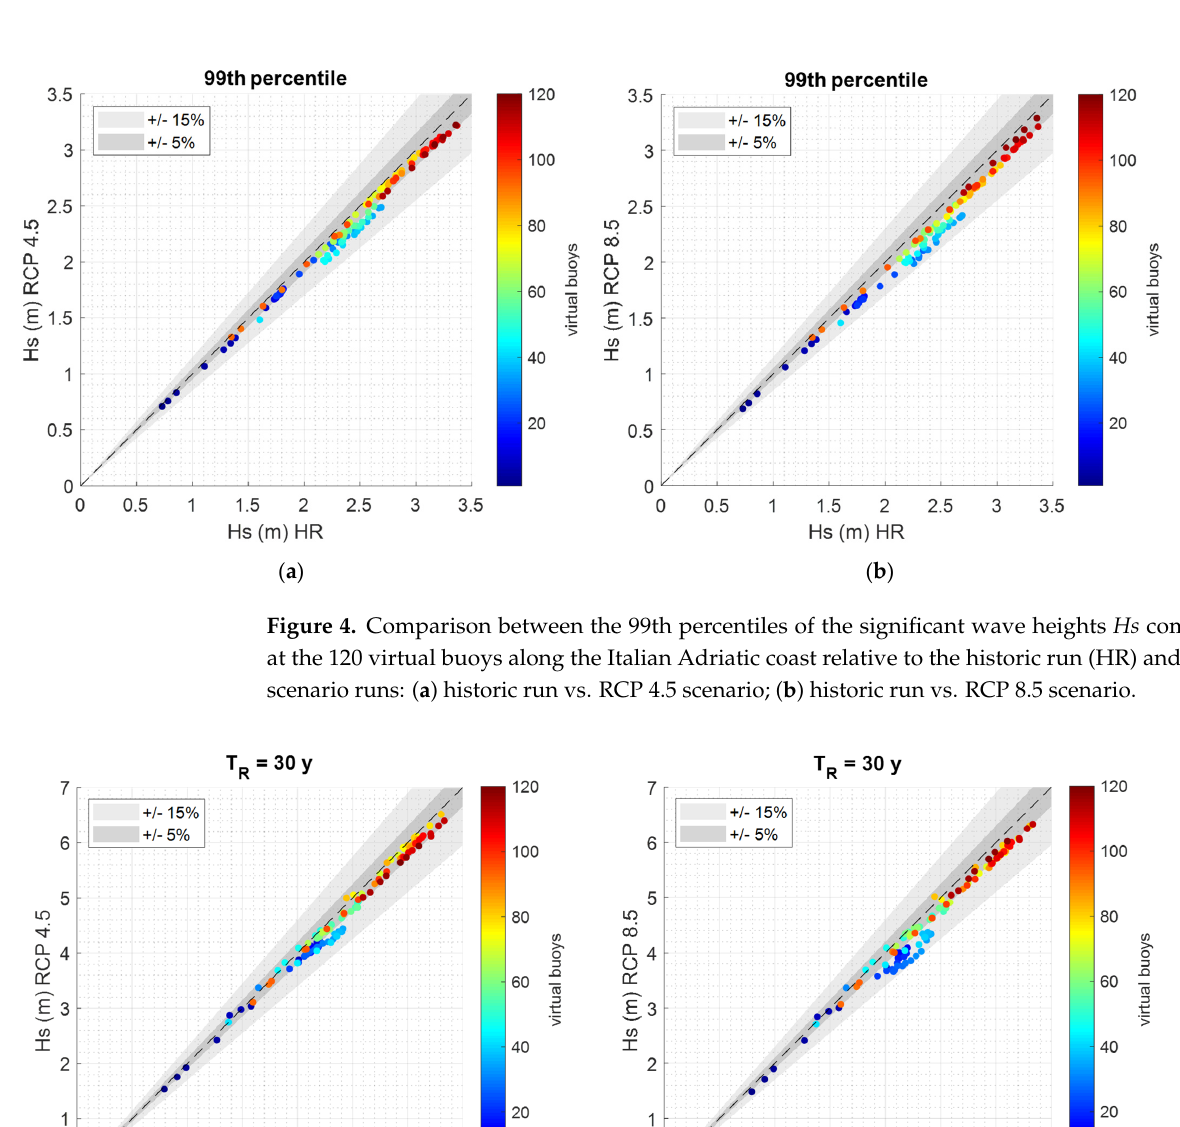
Figure 4. Comparison between the 99th percentiles of the significant wave heights Hs computed at the 120 virtual buoys along the Italian Adriatic coast relative to the historic run (HR) and future scenario runs: ( a ) historic run vs. RCP 4.5 scenario; ( b ) historic run vs. RCP 8.5 scenario.